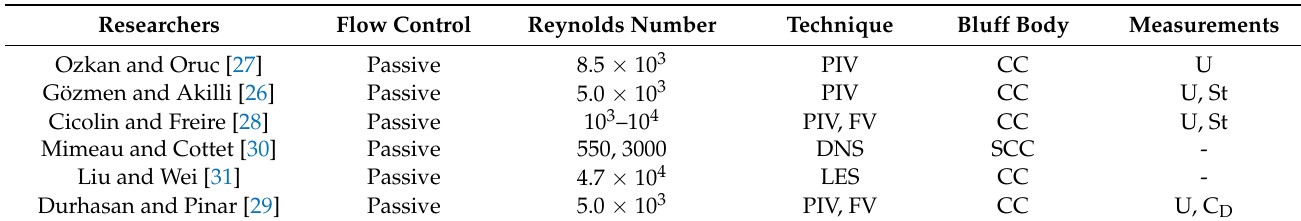
FV = flow visualization; PIV = particle image velocimetry; DNS = direct numerical solution; LES = large eddy simulation; St = Strouhal number; C D = drag coefficient; CC = circular cylinder; SCC= semicircular